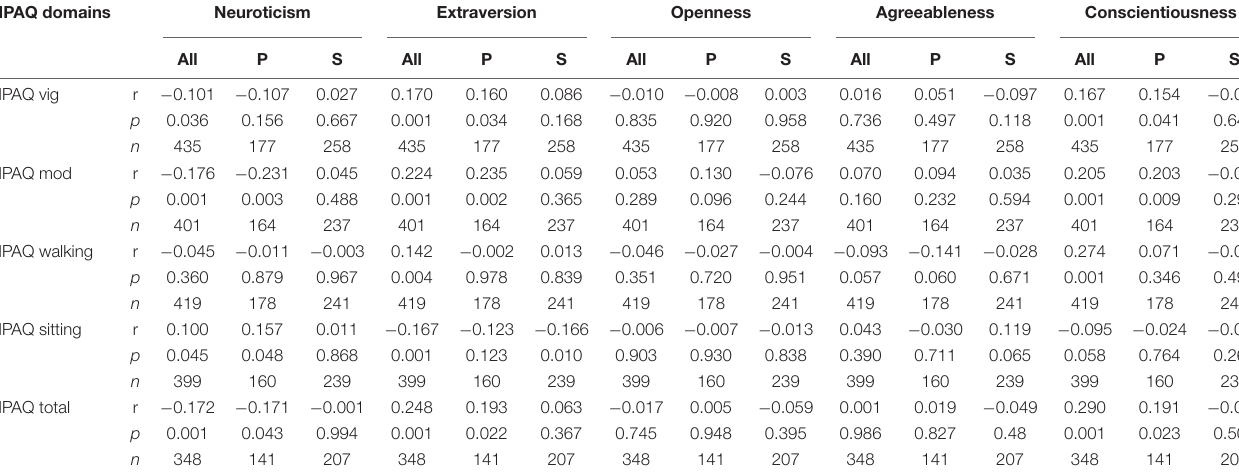
TABLE 2 | Personality traits (NEO-FFI) and the level of physical activity (IPAQ) among Polish and Spanish PE students (Pearson’s correlation coefficient analysis). IPAQ domains Neuroticism Extraversion Openness Agreeableness Conscientiousness